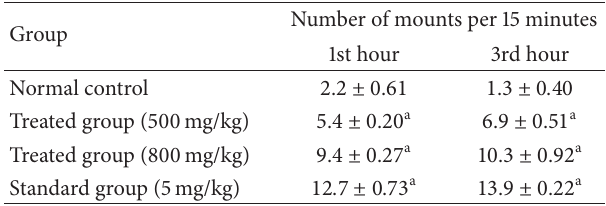
Table 1: Effect of Cydonia oblonga on the mounting behaviour of male rats on the 14th day of the study.